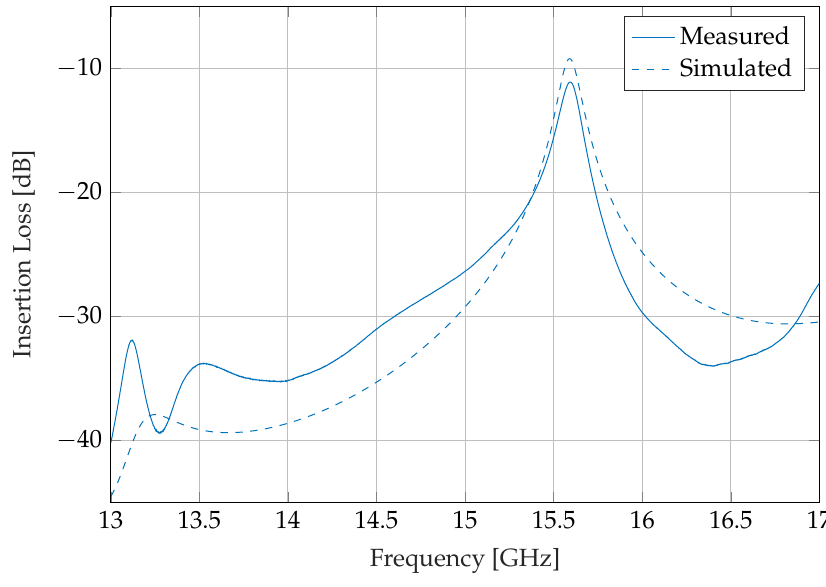
Figure 9. Frequency response of the empty